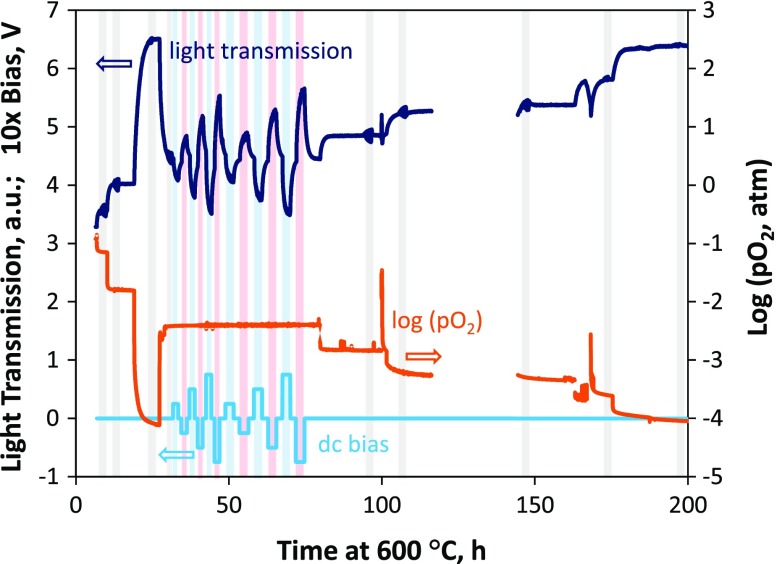
Overview of the raw data obtained during the first measurement run at 600 °C on the pre-aged STF35 film. Measured light transmission (dark blue, left axis) is shown to change over time in response to changes in both gas oxygen partial pressure (orange curve, right axis) and DC bias across the substrate (light blue curve, left axis). Shaded areas indicate times during which AC-impedance measurements were performed (blue shaded for positive DC bias and red shaded for negative DC bias).